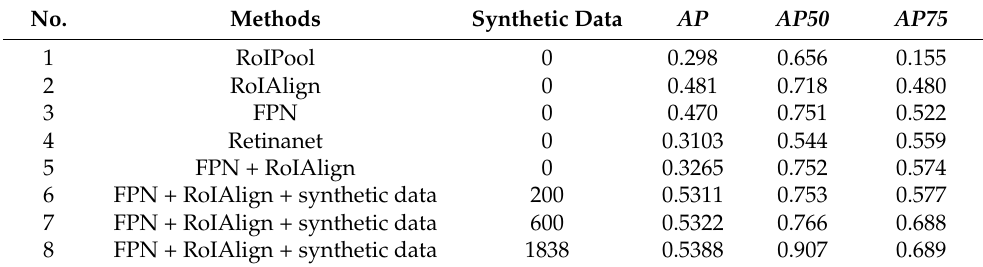
Table 2. Comparison of oil detection without labeling in the training set.